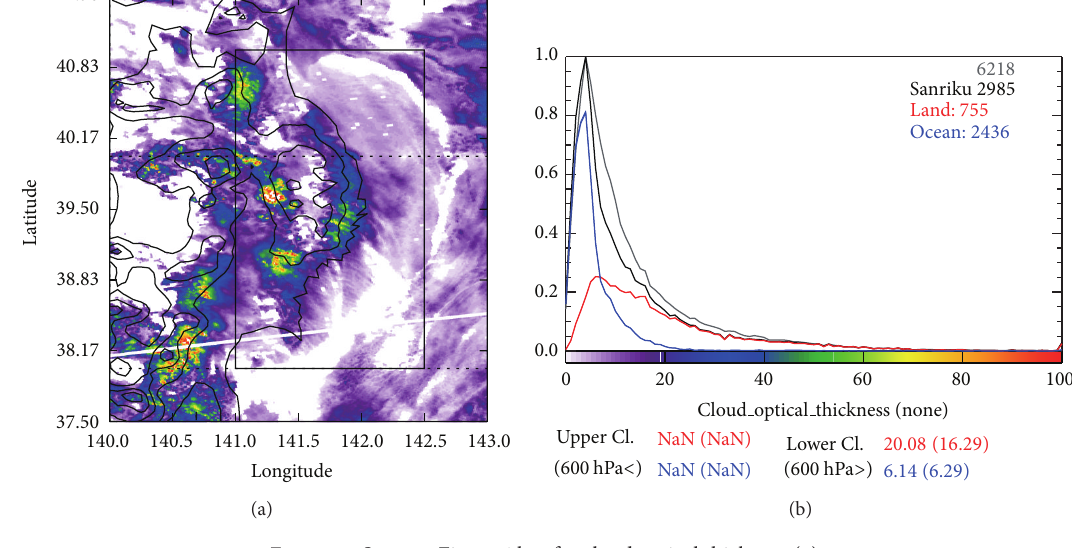
Figure 5: Same as Figure 4 but for cloud optical thickness ( 𝜏